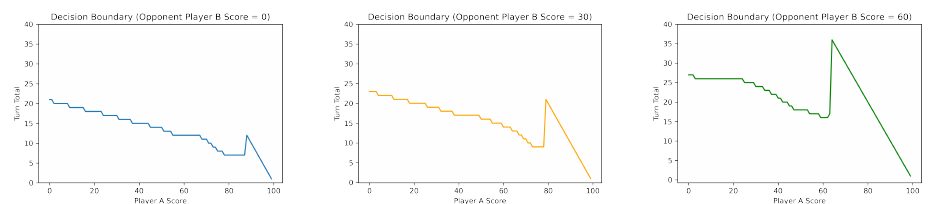
Figure 3. The roll/hold boundary for Player A who goes first when the opponent Player B’s score is